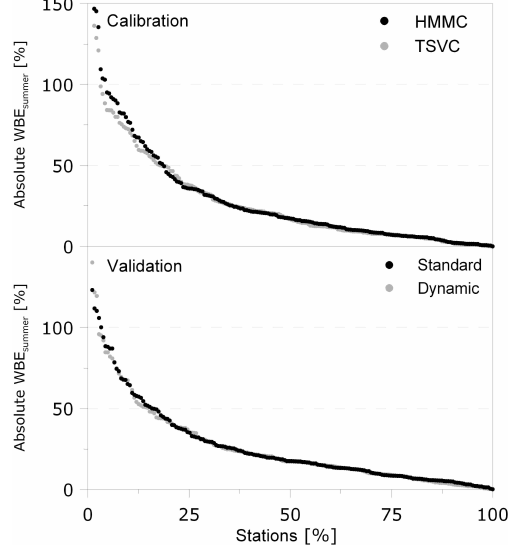
Fig. 14. Sorted model performance for NSE and absolute WBE both models for the proxy basin application to model domain 2 during the validation period.